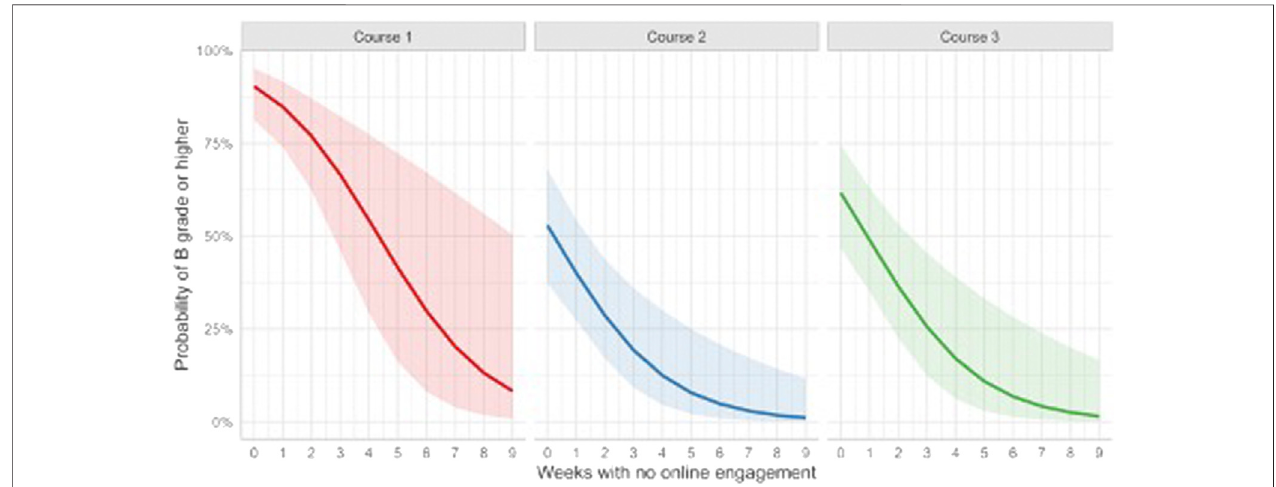
FIGURE 2 | Relationship between student achievement and the number of weeks with no online engagement. Estimates obtained from a generalized linear mixed model (binomial distribution, logit link). The shaded regions represent 95% con fi dence intervals.